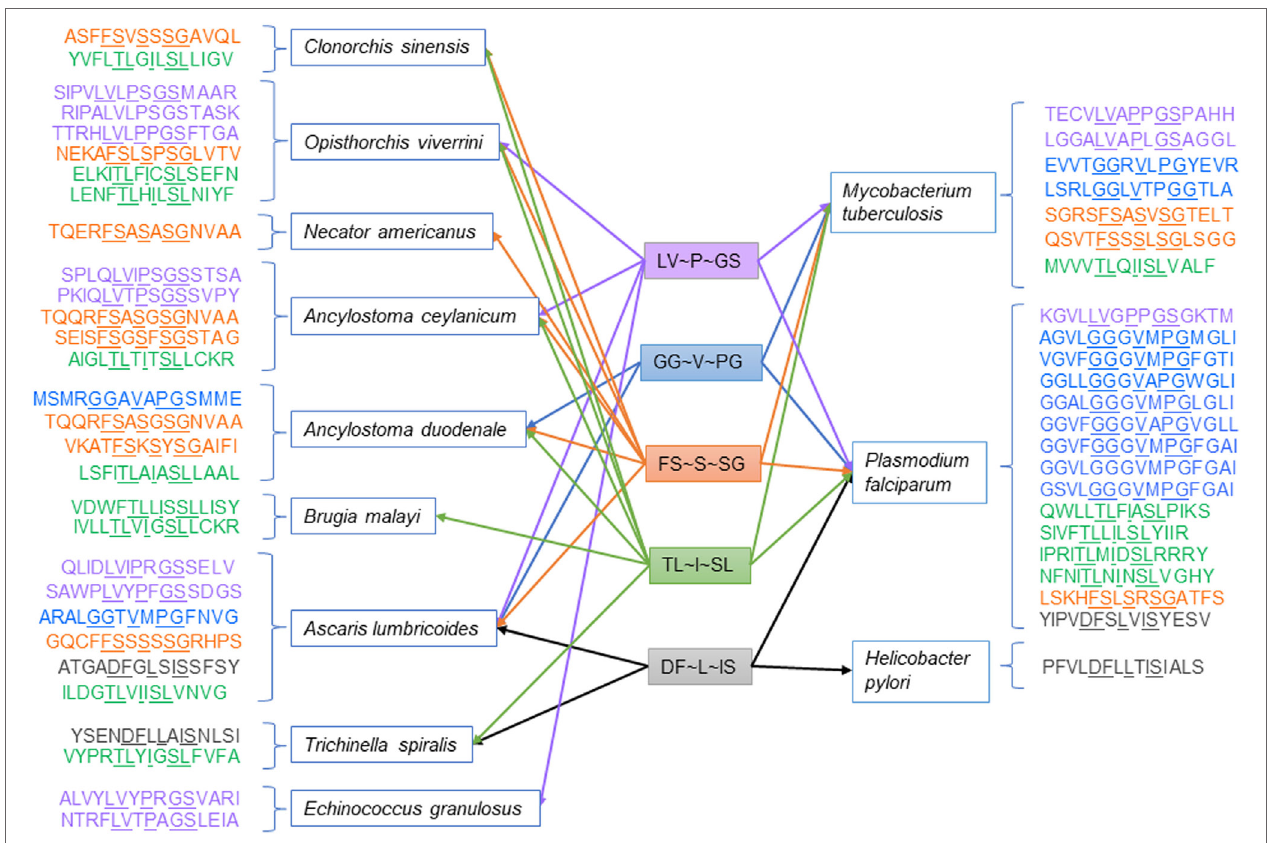
FigUre 4 | Illustration of networking among high suppressive index T-cell-exposed motifs in helminths and selected